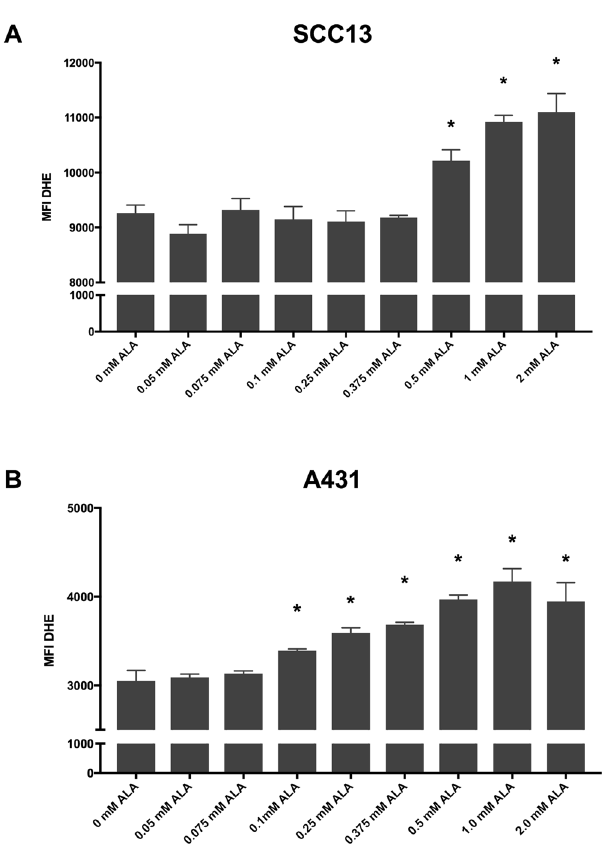
Table 2. ROS generation of 5-ALA treated samples at variable concentrations. Abbreviations: 5-ALA – 5-aminolevulinic acid, ROS – Reactive Oxygen Species, MFI – Median Fluorescent Intensity. P < 0.05 denoted by asterisk ( * ).